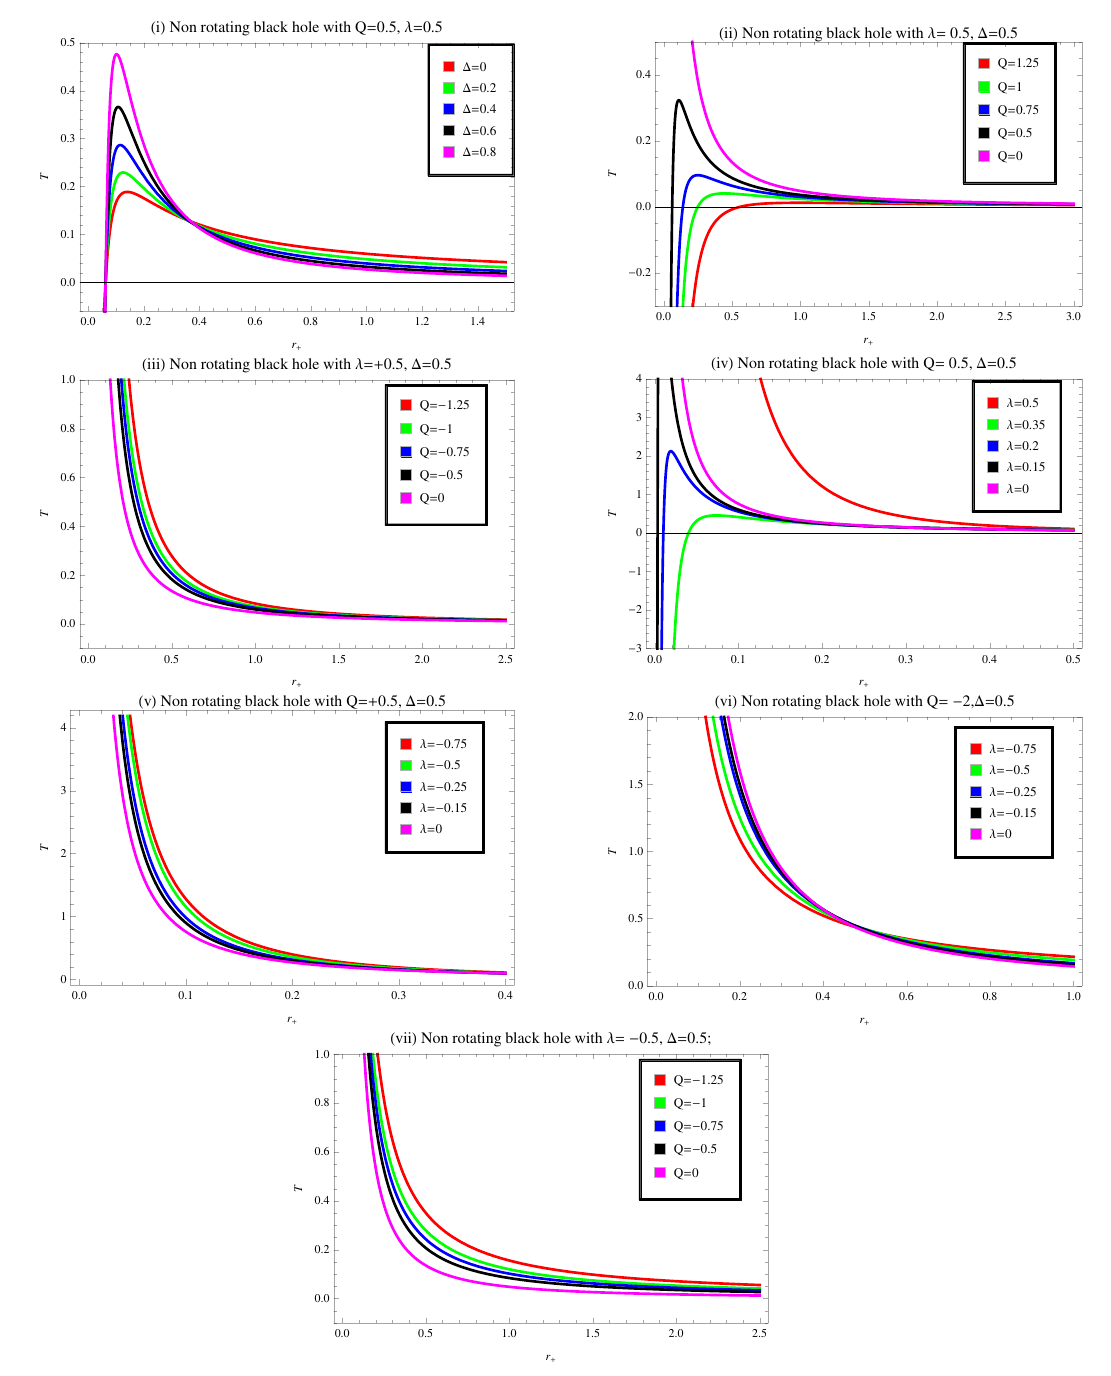
Figure 2. Plot of temperature T versus horizon radius r + for non-rotating BH for various choices of λ , ∆ and Q . Plots (iv) and (v) reveal the nature of temperature for a fix value of Q = 0.5, ∆ = 0.5 with ( λ ≥ 0 ) and ( λ ≤ 0 ) , respectively. From plot (iv), the curves for λ = 0, 0.5 represent the decreasing positive behavior, which is a physically acceptable solution while all the remaining trajectories show the same behavior as in plot (ii). In plot (v), the temperature function shows the same behavior as in plot (iii). Plots (vi) and (vii) illustrate the